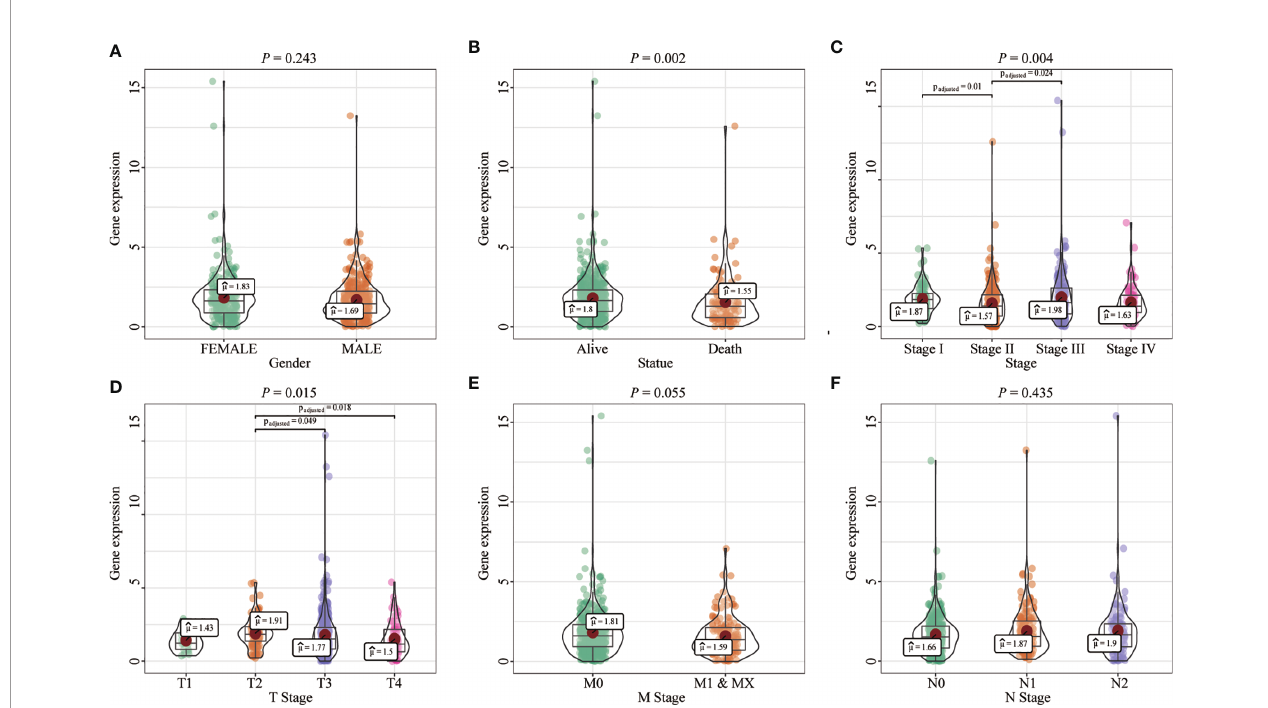
FIGURE 3 | Correlation between fetal-lethal non-coding developmental regulatory RNA (FENDRR) expression and clinicopathological characteristics in patients with colon adenocarcinoma/rectum adenocarcinoma (COAD/READ). (A – F) Association of FENDRR expression with poorer survival ( p = 0.002), higher tumor stage ( p = 0.004), T stage ( p = 0.015), M stage ( p = 0.055), N stage ( p = 0.435), and ( p =